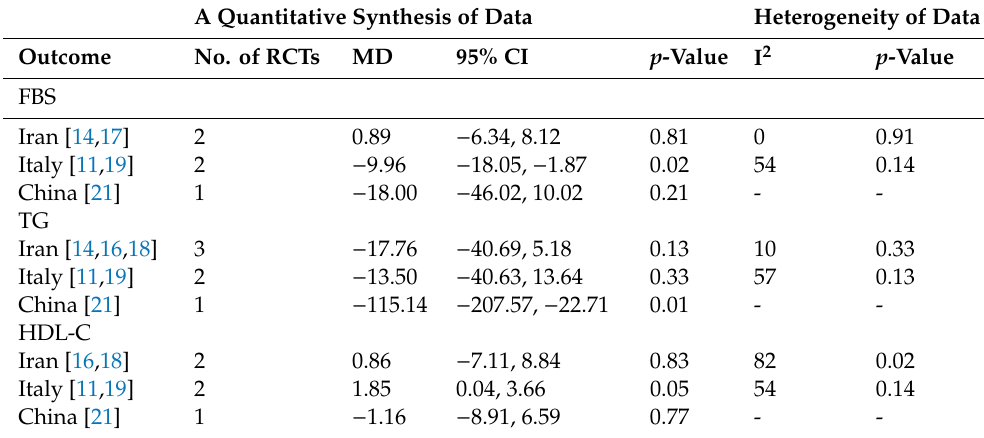
Table 3. Subgroup analysis by